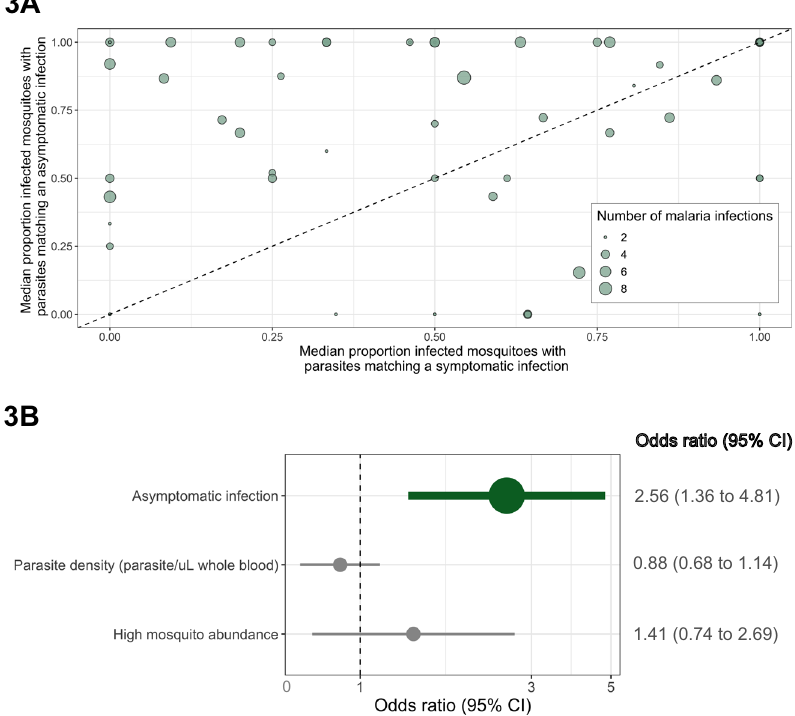
Fig. 3 Comparison of the proportion of infected mosquitoes harboring a matching pfcsp haplotype for participants with both asymptomatic and symptomatic infections. A Scatterplot of the proportion of pairings with a mosquito that shared a minimum of one haplotype for asymptomatic ( y -axis) and symptomatic ( x -axis) infections. Each dot is a participant who suffered at least one asymptomatic and symptomatic infection, and for participants with more than one of either type of infection, the plotted value is the median of proportions across infections within that type. Size of dots is relative to the total number of the participant ’ s infections. B Odds ratios of the proportion of matched mosquitoes in a multi-level logistic regression model using the continuous coding of the proportion of participant – mosquito pairings that shared haplotypes for each infection ( N = 1565 participant – mosquito pairings). Data are presented as odds ratios (dots) with 95% con fi dence intervals